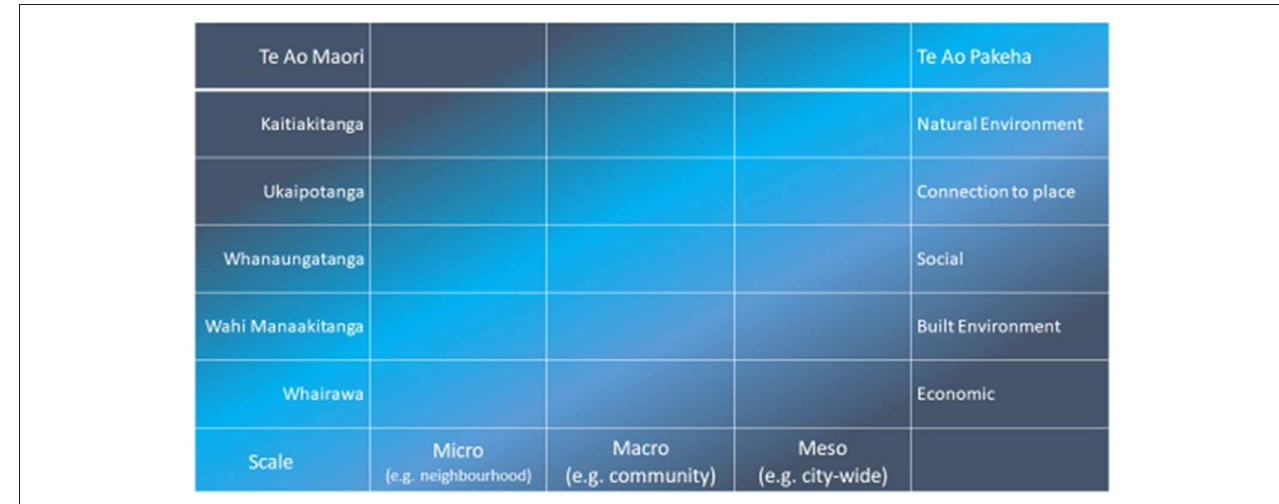
FIGURE 1 | A conceptualized view of the scales, dimensions, and World-views of urban